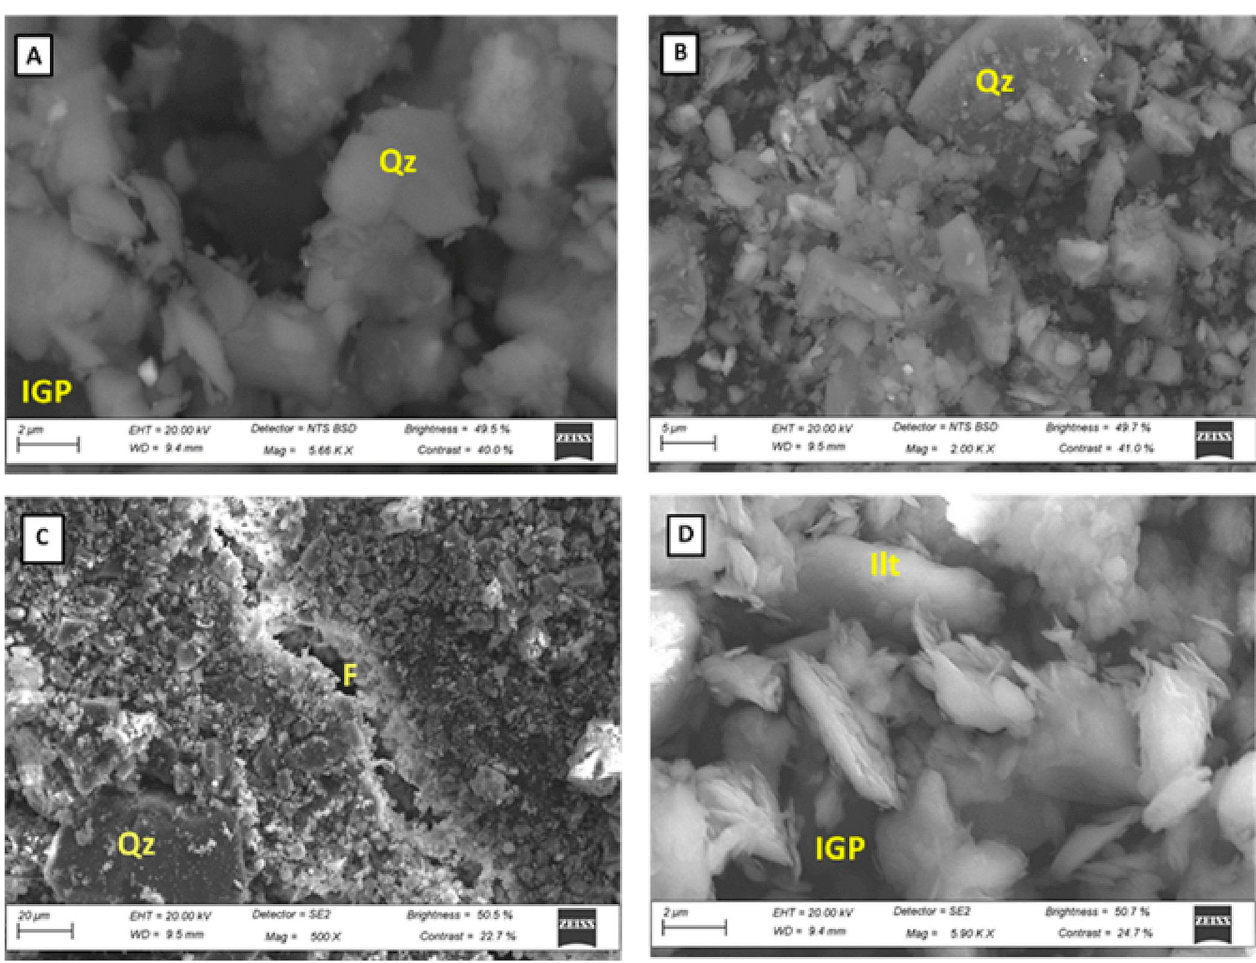
Figure 10. Scanning Electron Microscope (SEM) images: ( A ) Well MO7, 2427 m, intergranular pores (IGP) in slightly altered quartz (Qz) grains; ( B ) Well MO7, 2430 m, Finer grains of monocrystalline quartz derived from the coarser polycrystalline quartz (Qz) grains; ( C ) Well MO9, 2369 m, authigenic quartz (Qz), intergranular fracture (F) within finer quartz grains; ( D ) Well MO9, 2441 m, intergranular porosity (IGP) within plated illite (Ilt)